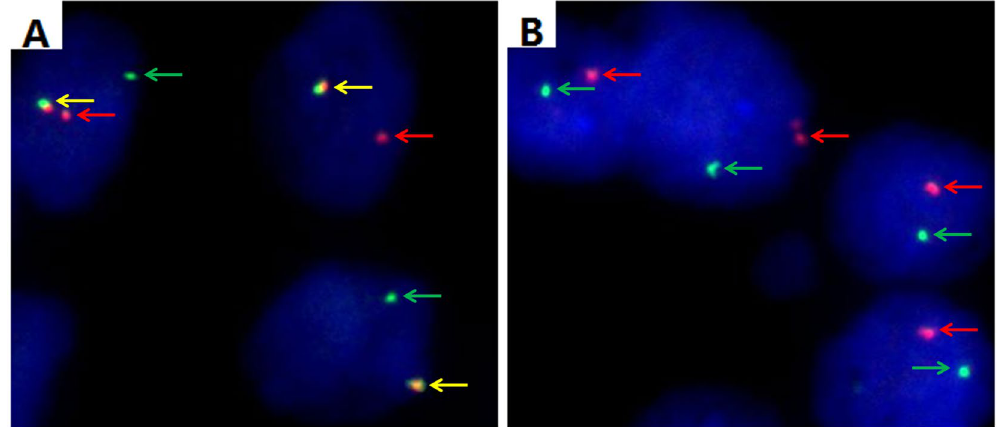
Figure 1. Representative images of the TFE3 break-apart probe assay. ( A ) Separate red and green signals (indicated by the respective arrows) and normal co-hybridization signals (yellow arrows) indicate that one X chromosome harbors the translocation and the other is normal in a female patient ( × 1000). ( B ) Separate red and green signals (indicated by the respective arrows) indicate that the only X chromosome harbors the translocation in a male patient ( × 1000); TFE3, transcription factor